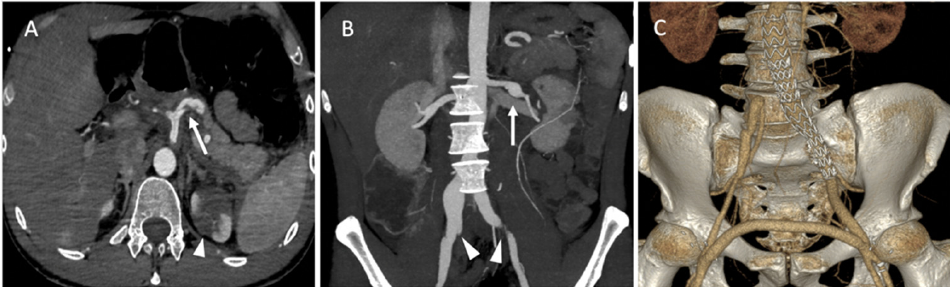
Figure 8. ( A ) Axial abdominal CT images in the arterial phase showing a celiac trunk dissection extended to the hepatic and splenic arteries (arrows) with renal ischemia; ( B ) coronal abdomen and pelvis CT images in the arterial phase showing common right and left iliac artery dissection (arrowheads); ( C ) the abdominal angiogram CT with 3D imaging reveals the left hypogastric embolization by coils and the endovascular exclusion of the left iliac artery with an aorto-iliac end prosthesis. The contralateral iliac artery was embolized with second-generation plugs and femoro-femoral bypass from left to right.